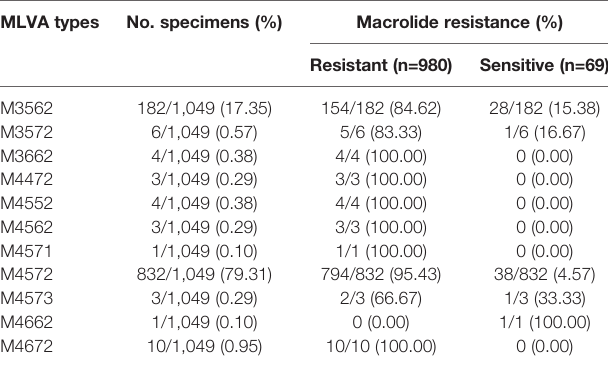
TABLE 2 | MLVA types and macrolide